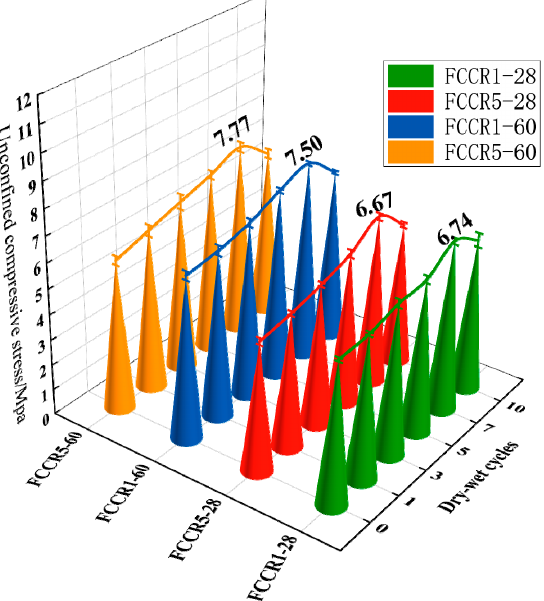
Figure 4. UCS of specimens under different durability conditions.